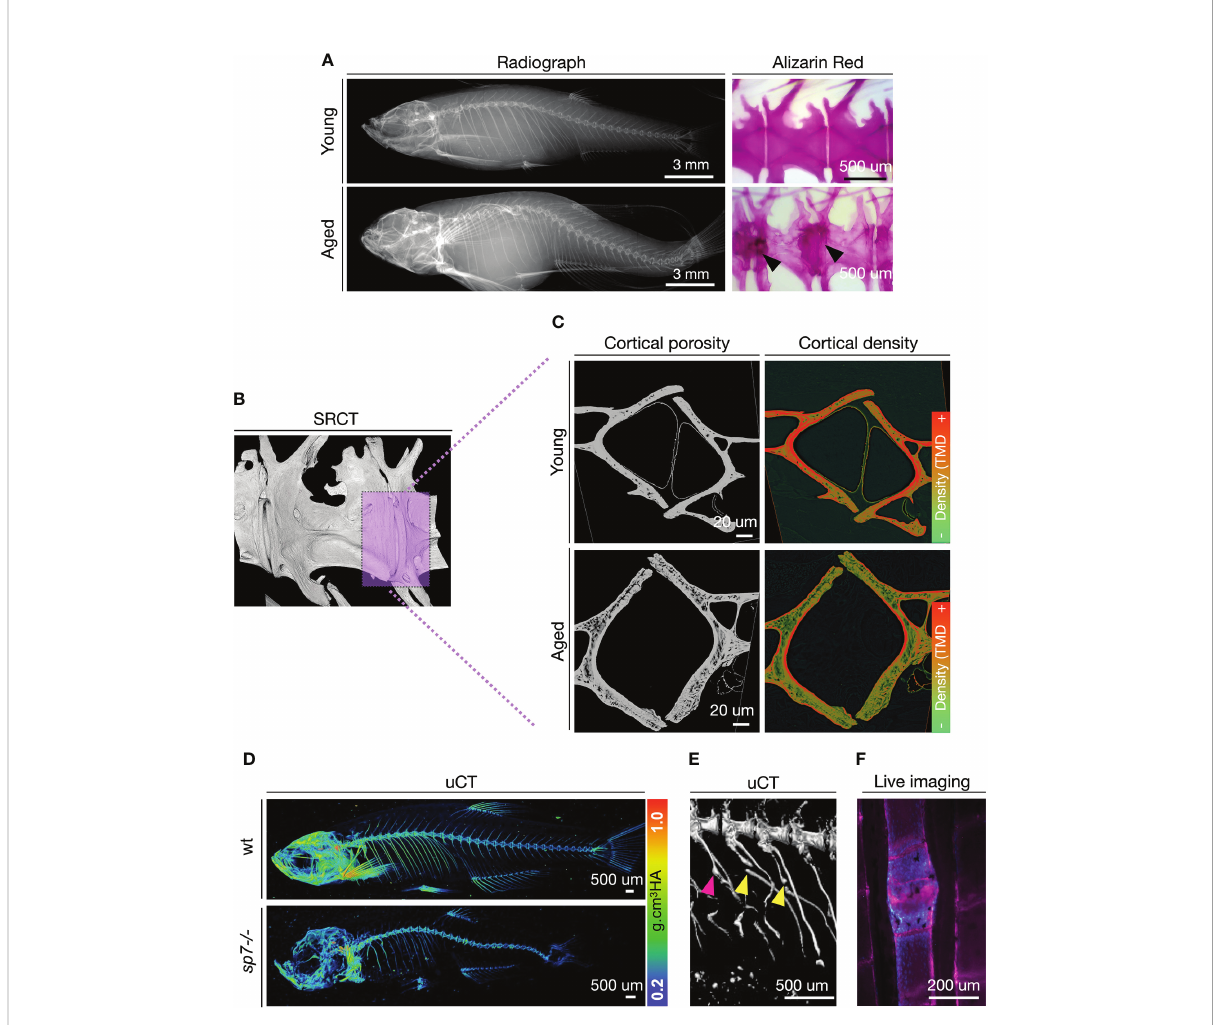
FIGURE 3 Zebra fi sh develop bone microarchitecture deterioration during aging, and young zebra fi sh mutants are used to study osteoporosis-associated genes. (A) Radiographs and Alizarin Red Staining of young (1 year = ~30 human years) and aged (3 years = ~80 human years). Alizarin red staining from Kague et al. (123). Note bone sclerosis in endplates of aged spines (arrowhead). (B) Synchrotron radiation µCT of a region of interest in the zebra fi sh spine. The magenta box shows a selected region for a digital cross-section. (C) Digital cross-sections of the endplate region of the zebra fi sh vertebral column to show cortical porosity (greyscale) and density (colored by pixel grey intensity). TMD, Tissue Mineral Density. Regions of higher densities are shown in red, while lower densities are in green. (D) Micro-computed tomography (µCT) of young (3 months old) wild-type (wt) and sp7-/- mutant with values of tissue mineral density (cortical density). µCT images from Kague et al. (123). (E) Fractures are observed in ribs of sp7-/- mutants. Fractures (yellow arrowhead), calluses (magenta arrowhead). (F) Example of a fracture in the zebra fi sh caudal fi n imaged from live fi sh. Calci fi ed bone was stained with Alizarin Red (magenta) and osteoblasts (blue) are labeled with Tg( sp7: gfp ) reporter line. Scale bar is represented in each